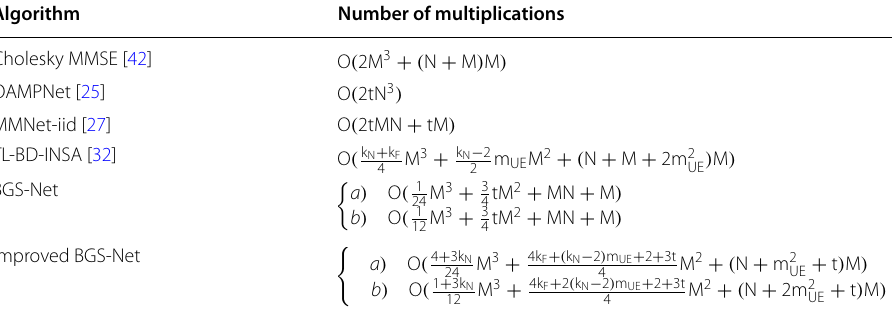
Table 1 Computational complexity comparison Algorithm Number of